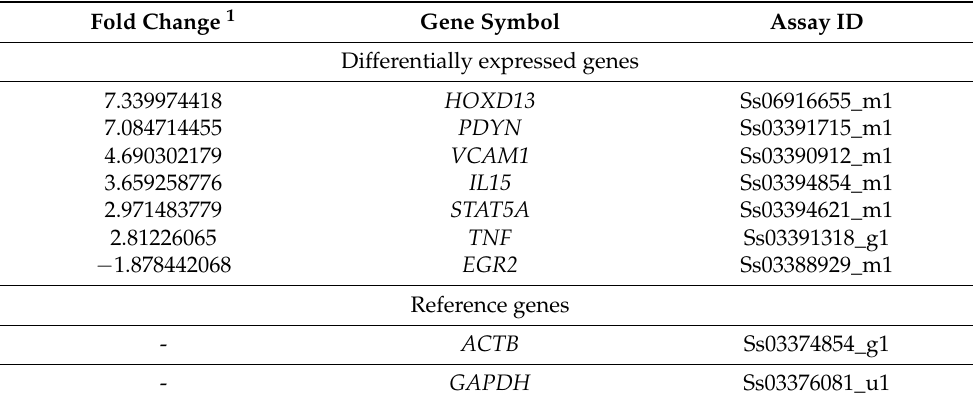
Table 2. Taq Man probes used in the validation of the NGS results experiment. Fold Change 1 Gene